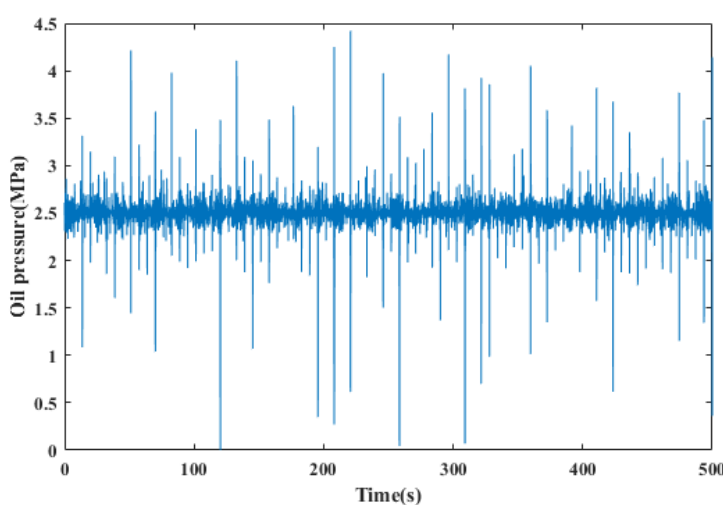
Figure 19. Current tracking effect when driving on sloping terrain.